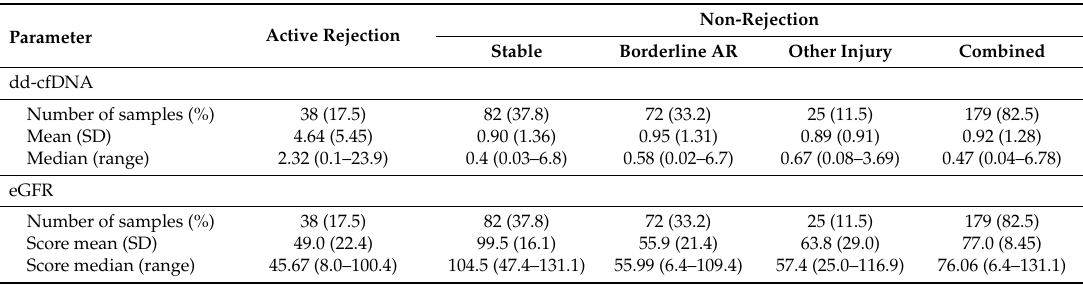
Table 2. Summary statistics for donor-derived cell-free DNA (dd-cfDNA) and estimated glomerular filtration rate (eGFR) variables across AR and non-rejection